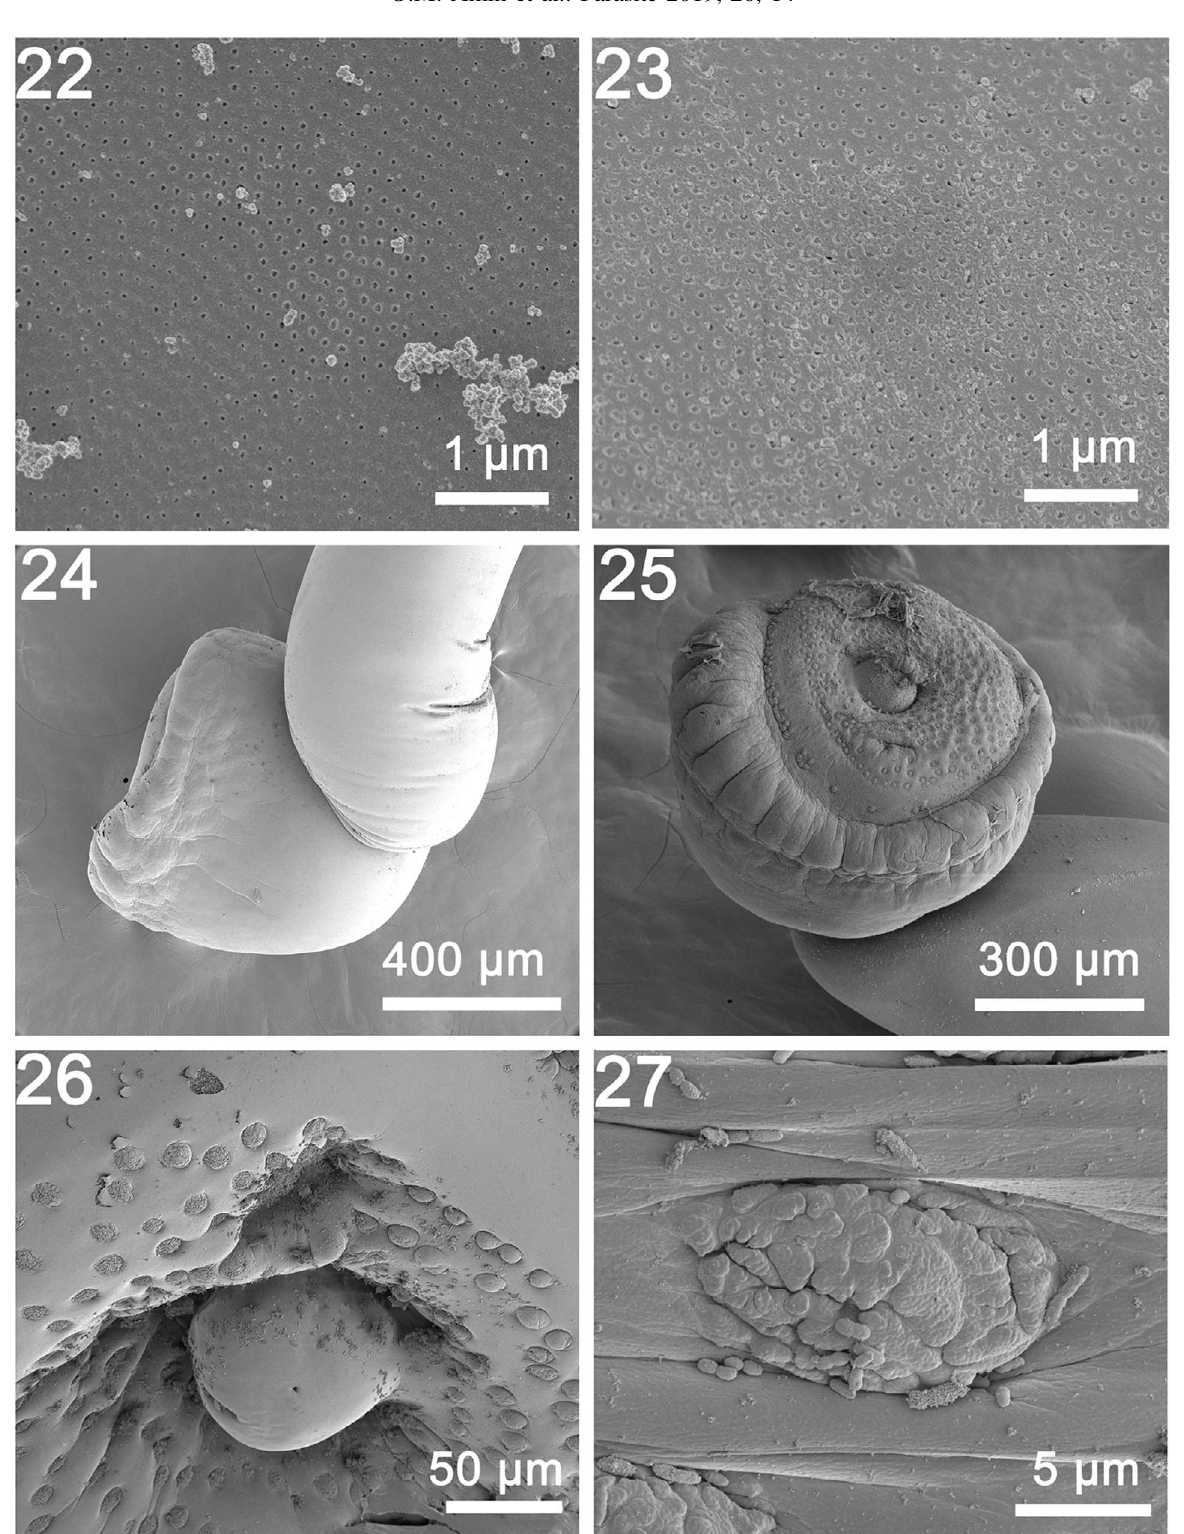
Figures 22 – 27. SEM of specimens of Rhadinorhynchus laterospinosus from Auxis rochei and Auxis thazard in the Paci fi c Ocean off Vietnam. (22, 23) Microspores from the middle and posterior parts of the trunk, respectively. Note the different density and diameter of the pores, also compared with Figure 18 related to differential absorption rates. (24) A lateral view of the bursa. (25) A ventrolateral view of a bursa showing its thick muscular margin and the organization of the outer circle and the central cluster of sensory papillae. (26) A high magni fi cation of the center of the bursa showing the terminal genitalia surrounded by close circles of sensory papillae. This organization is species-speci fi c. (27) A higher magni fi cation of one sensory papilla made up of small units embedded in elliptic